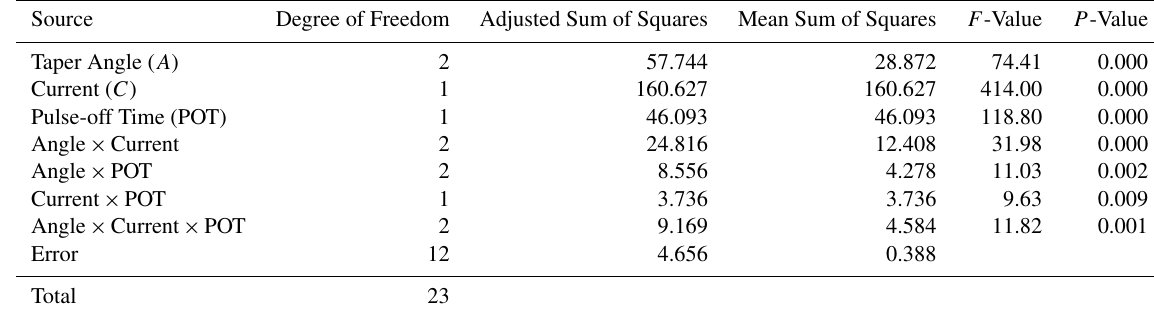
Table 6. Analysis of Variance for MRR.